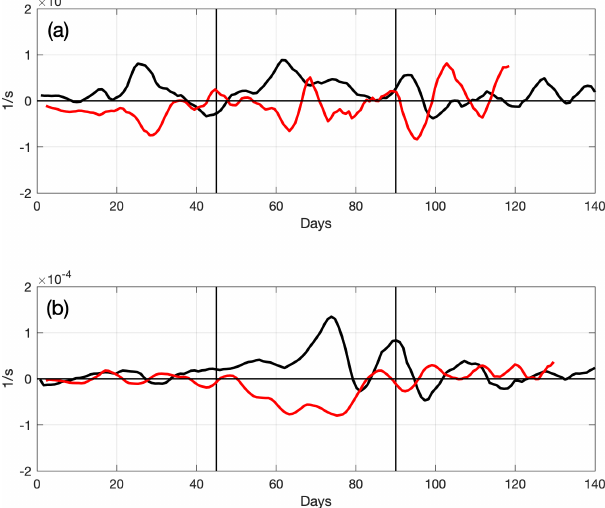
∂ξ , red line) and the f ∂t ∂h , black line) for H − h ∂t